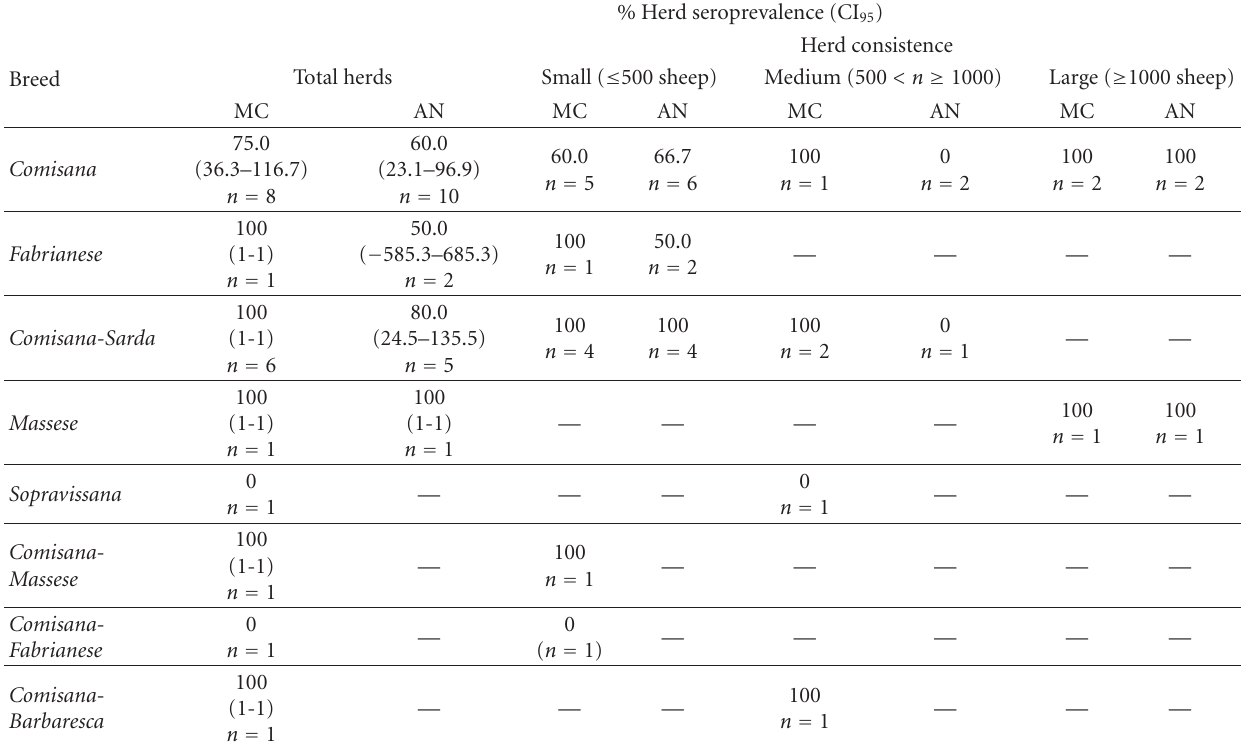
Table 4: Herd seroprevalence in relation to the breed and herd consistence in Macerata and Ancona provinces. % Herd seroprevalence (CI 95 )